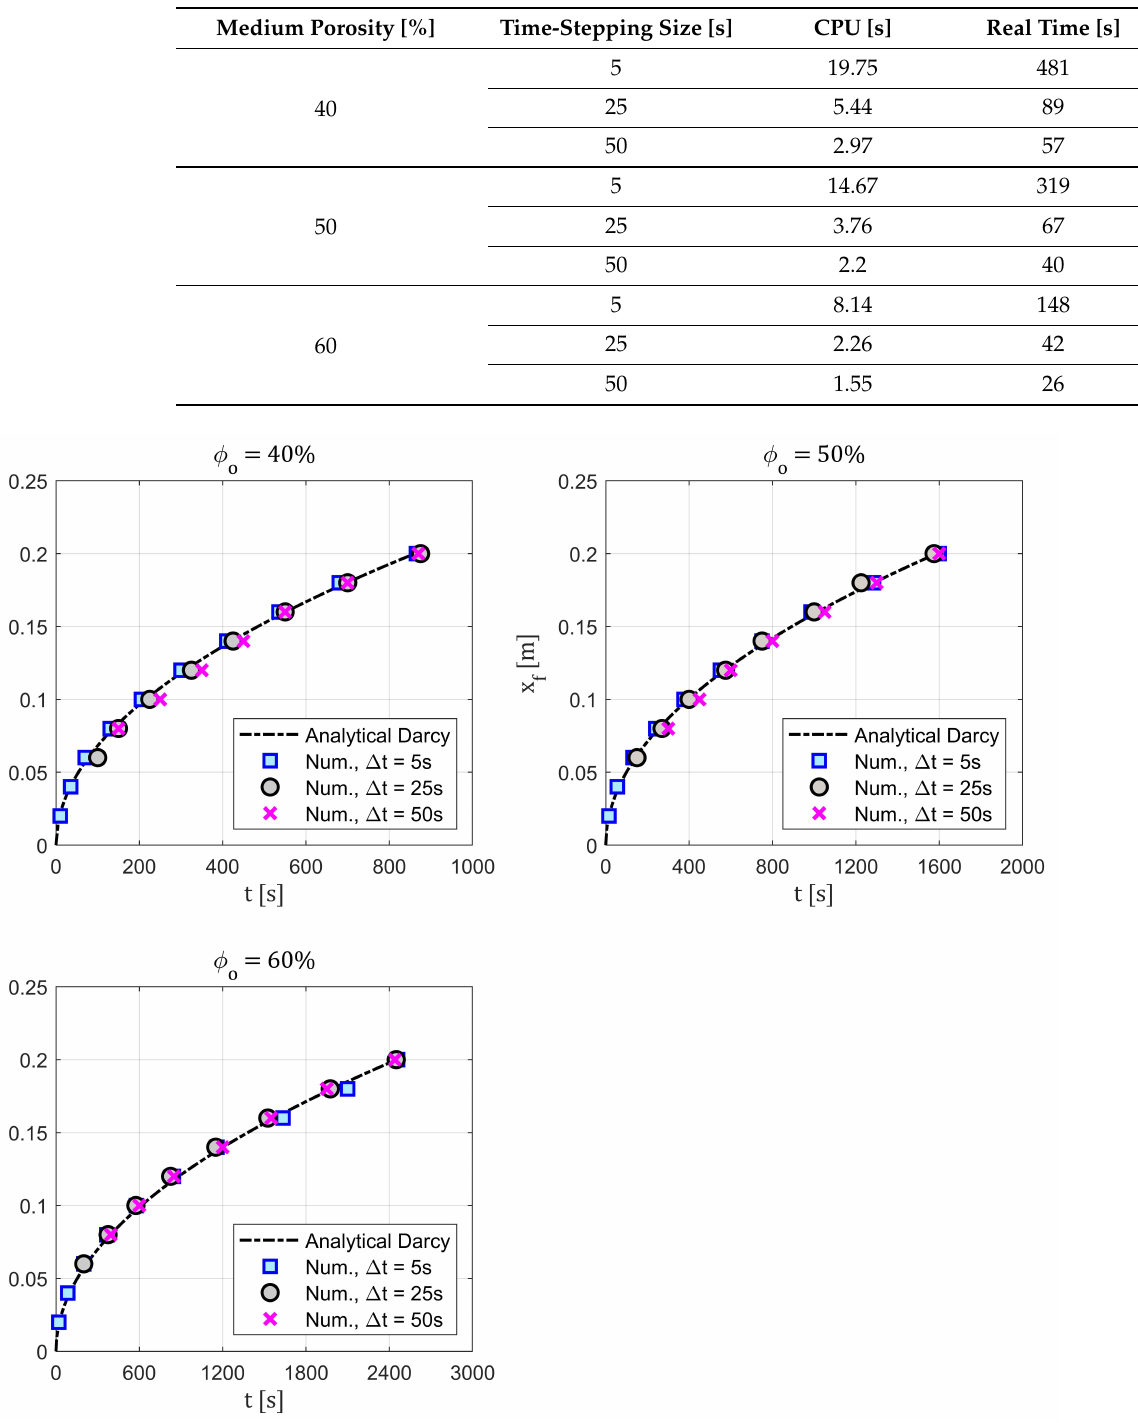
Table 2. Computational processing time with different time-stepping sizes for each medium porosity.